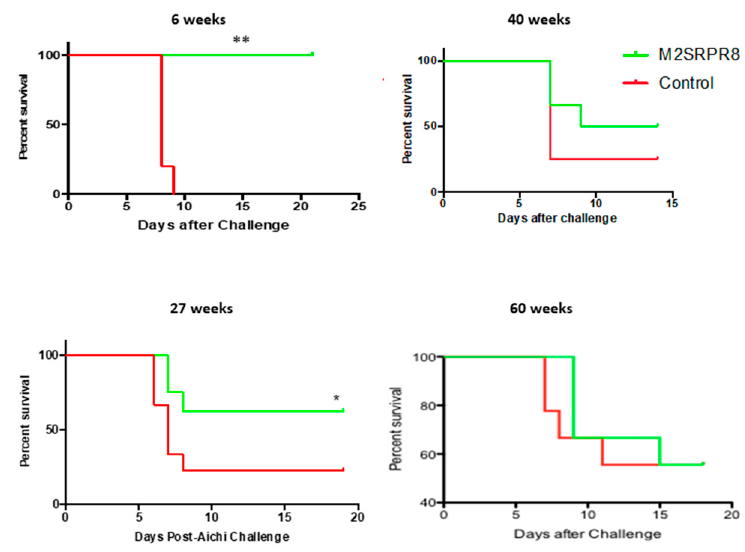
Figure 6. Duration of heterosubtypic protection induced by single-replication influenza virus. Groups of 6–10 mice were vaccinated with M2SR-PR8 as described above. After 6, 27, 40, or 60 weeks, the mice were challenged with 40 MLD 50 of live, wildtype Aichi. Their survival was monitored for 15–21 days after challenge. Note: * significantly different from unvaccinated control p < 0.05, ** p < 0.01 (Mantel–Cox log rank test).